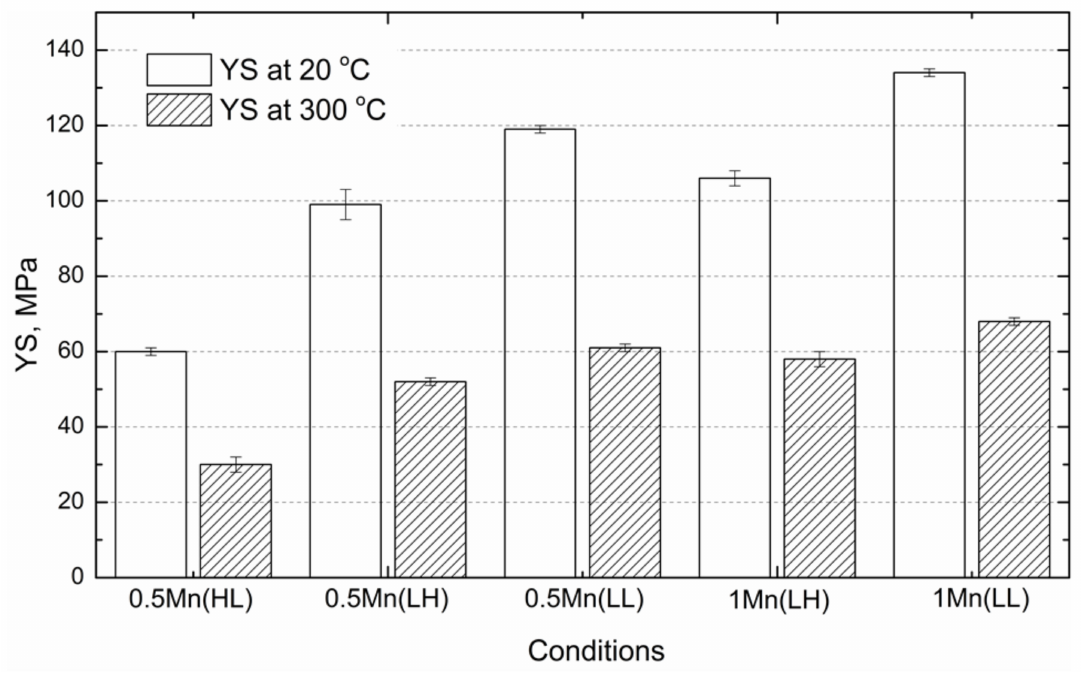
Figure 6. Room- and elevated-temperature YS of experimental alloys after thermal exposure at 300 ◦ C/100